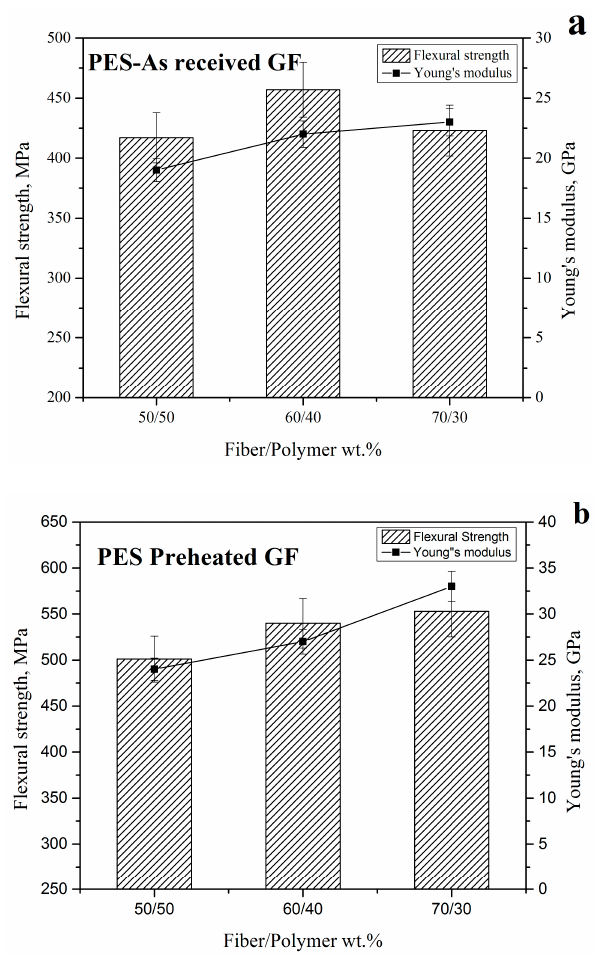
Figure 5. Flexural strength and Young’s modulus for composites reinforced with ( a ) as-received GF (route 3) and ( b ) preheated at 350 °C GF (route 4).